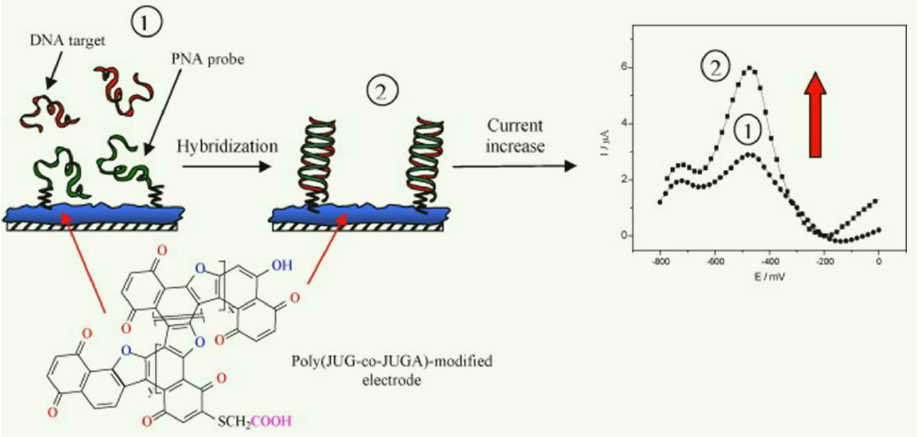
Figure 6. ( 1 ) Immobilization of the peptide nucleic acid (PNA) probe; and ( 2 ) hybridization of the target DNA onto poly(JUG- co -JUGA)-modified glassy carbon electrode (GCE) together with the corresponding square wave voltammetry (SWV) signals for ( 1 ) PNA probe immobilization, and ( 2 ) target DNA hybridization. (Reproduced with permission from [182]. Copyright 2014,